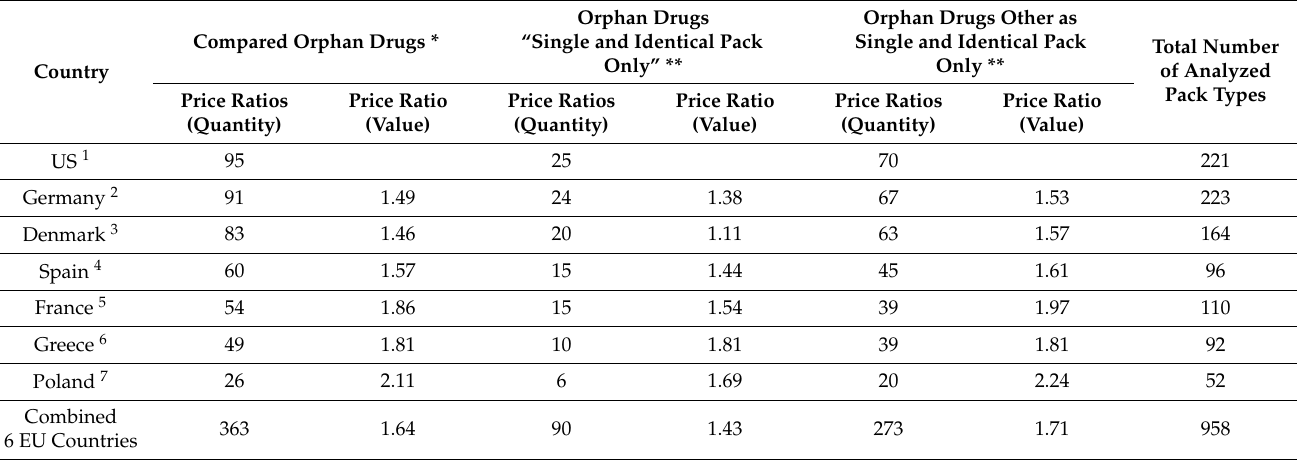
Table 3. Orphan Drugs price comparison: US vs. 6 EU Countries (Denmark, France, Germany, Greece, Spain,